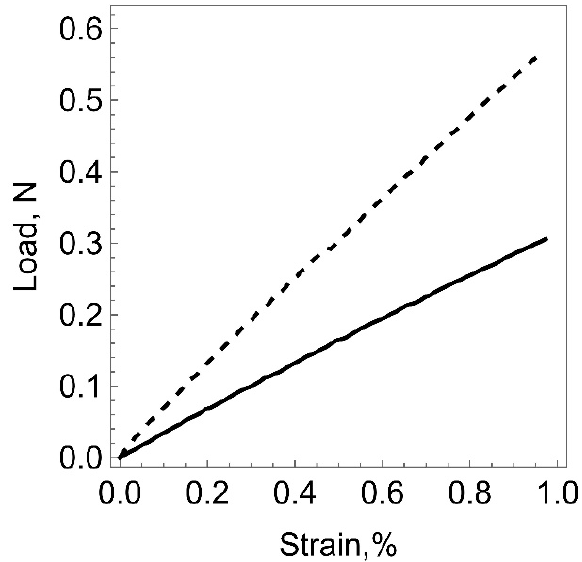
polyurethane surface after plasma treatment with a fluence of 10 15 ions/cm 2 are marked by red dots.